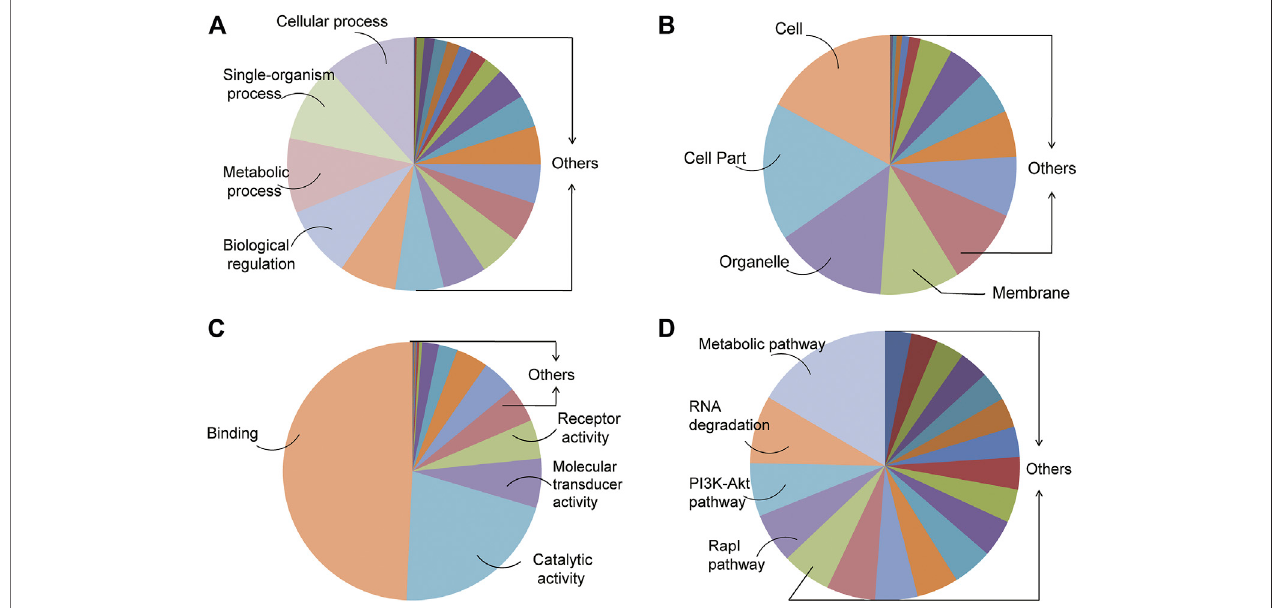
FIGURE4| GOandKEGGanalysisofgenestargetedbytheDEmiRNAs. (A – C) TopfourGObiologicalprocesses(BPs),cellularcomponents(CCs),andmolecular functions (MFs) enriched in target genes regulated by all the DE miRNAs. (D) KEGG enrichment analysis of signal pathways.